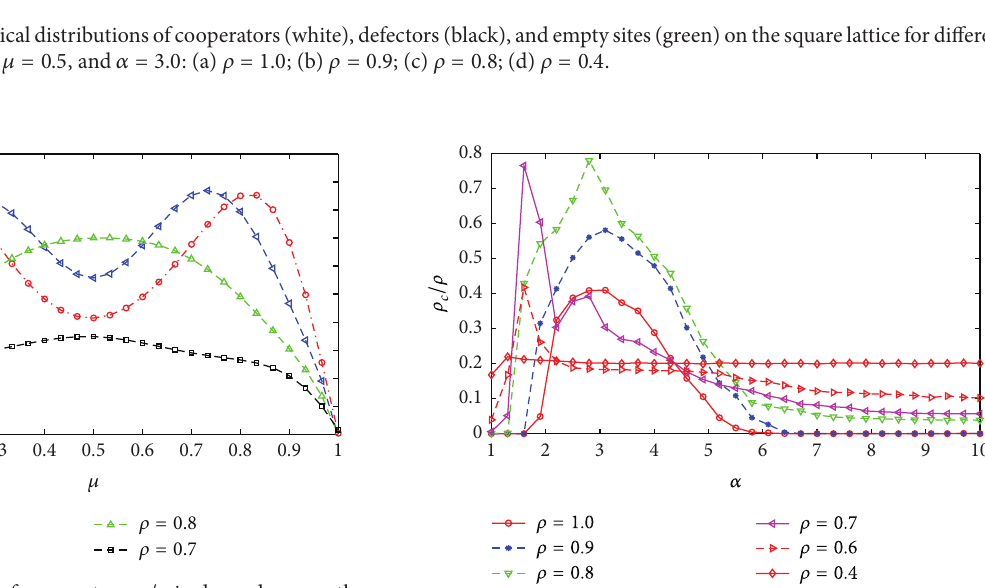
Figure 6: Relative density of cooperators 𝜌 𝑐 /𝜌 against 𝛼 for different values of 𝜌 when 𝑏 = 1.15 and 𝜇 = 0.5 (see legend). For the lower occupation densities, for example, 𝜌 = 0.4 , all isolated cooperator clusters are able to survive for all the values of 𝛼 . But it is worth noting that the relative density of cooperators varies nonmonotonically with the increase of 𝛼 when 𝜌 > 0.4 , which indicates that moderately enlarging the gaps among the social ranks can facilitate cooperation, while exceedingly large or small gaps inhibit cooperation. Moreover, although cooperation is possible in a wide range of 𝛼 for 0.6 ≤ 𝜌 < 1 , cooperation performs best when 𝜌 = 0.8 . we plot the histograms of the rank distribution for different values of 𝜌 by setting 𝜇 = 0.5 in Figure